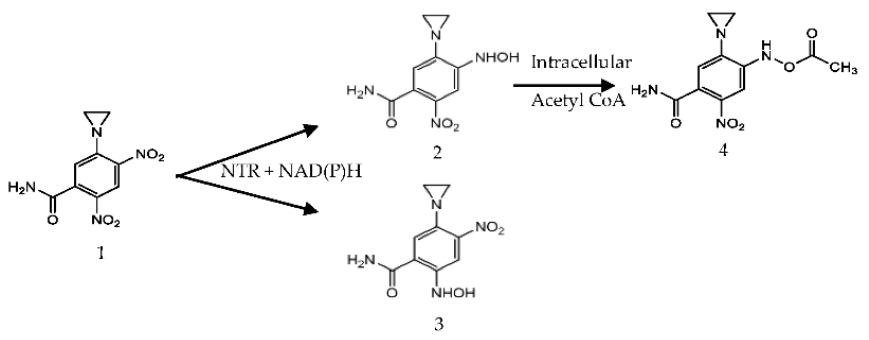
Figure 1. The reduction of CB1954 ( 1 ) into its products: 5-(aziridin-1-yl)-4-(hydroxyamino)-2- nitrobenzamide (2) 5-(aziridin-1-yl)-2-(hydroxyamino)-4-nitrobenzamide ( 3 ), product ( 2 ) can further reduce to 4-(acetoxyamino)-5-(aziridin-1-yl)-2-nitrobenzamide ( 4 ) the DNA cross linking species.